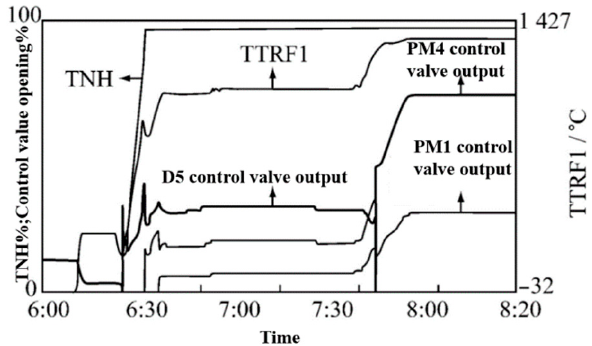
Figure 6. Combustion modes switching during unit startup [30]. Table 1. Operation mode of combustion chamber startup process.